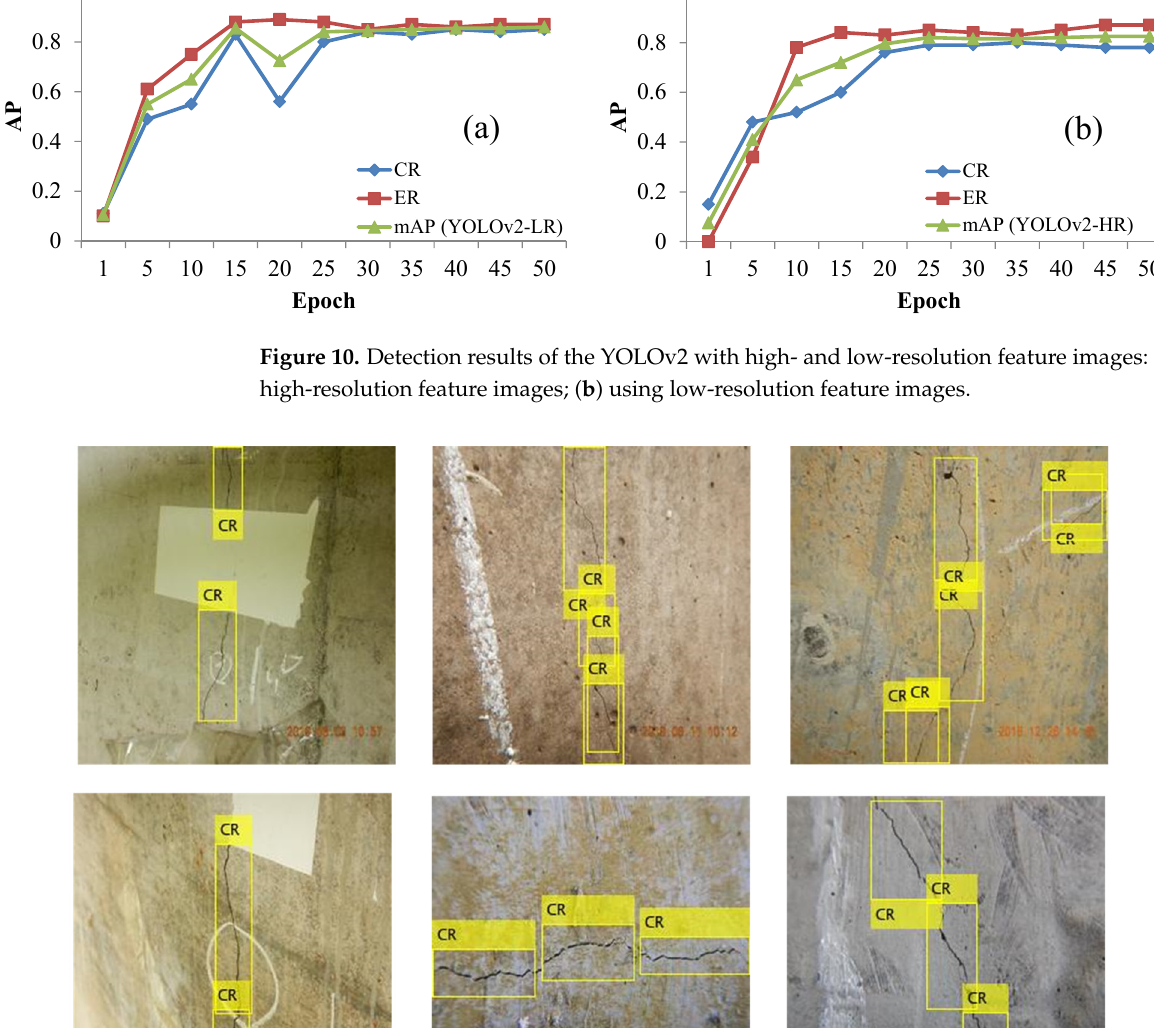
Figure 11. Partial detection results of CR and ER. Figure 12a (YOLOv2-HR) and Figure 12b (YOLOv2-LR) show the variation in the AP values of the YOLOv2 under the influence of 1~50 dB noise. It can be found that the AP value gradually decreased with the increase in noise intensity and finally approached 0. Interestingly, the rate of descent of the CR curve was higher than that of ER. Therefore, it can be inferred that CR detection is more susceptible to noise. Interestingly, the compari- sons of the YOLOv2-HR and YOLOv2-LR detection results (Figure 12c) indicate that the YOLOv2-HR had higher anti-noise ability, while the mAP of the YOLOv2-LR decreased faster than that of the YOLOv2-HR.